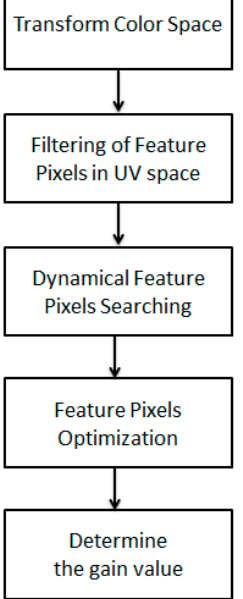
Figure 2. Flow chart of white balance method.